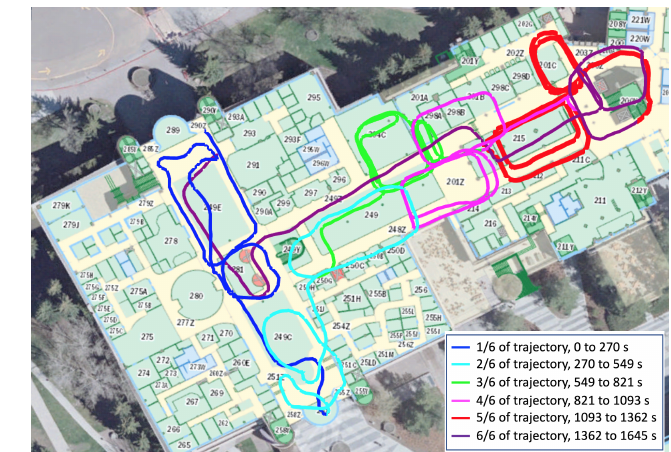
Figure 5. One test trajectory.